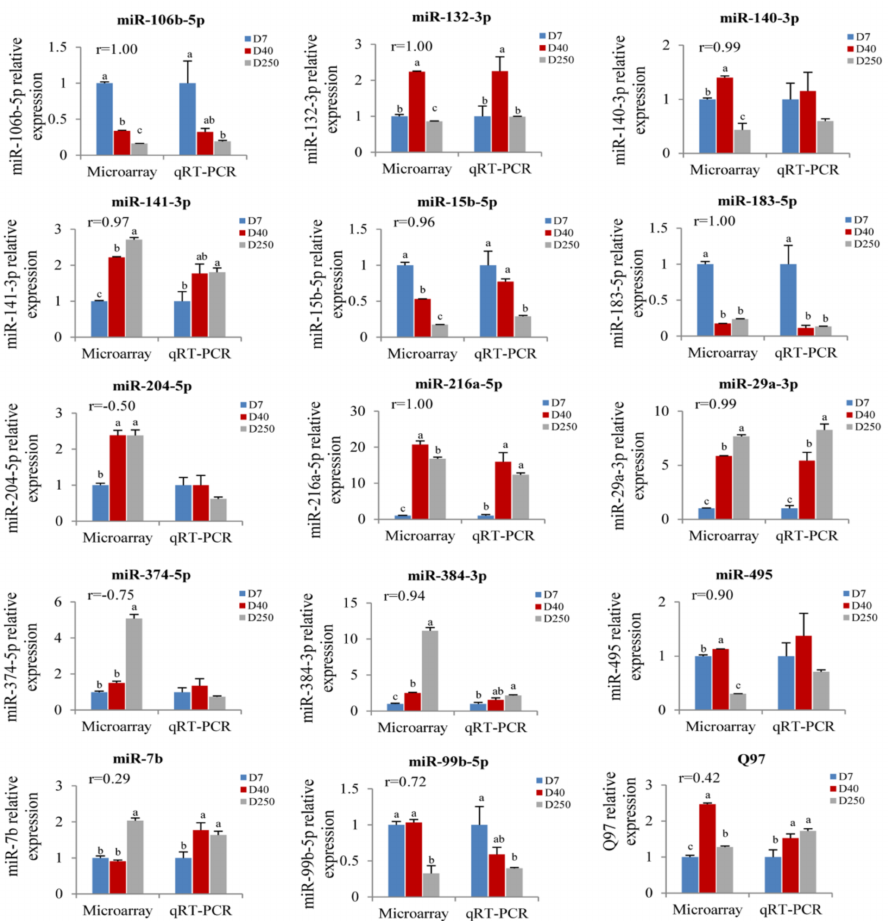
Figure 5. Validation of the microarray results by real-time PCR. Expression level of 15 miRNAs was detected by microarray (left) and real-time PCR (right). All data are represented as the means ± SEM. A Pearson correlation coefficient ( r ) was performed to determine the consistency between the real-time PCR and microarray data. The expression abundance on Day 7 was normalized to 1. Statistical significance was determined by a one-way ANOVA followed by a Tukey-HSD test. p < 0.05 was considered as statistically significant, and the column of each group with different letters and same letters, respectively, represent statistically significant and insignificant. The column with double letters means that this set of data is not significant with other two sets of